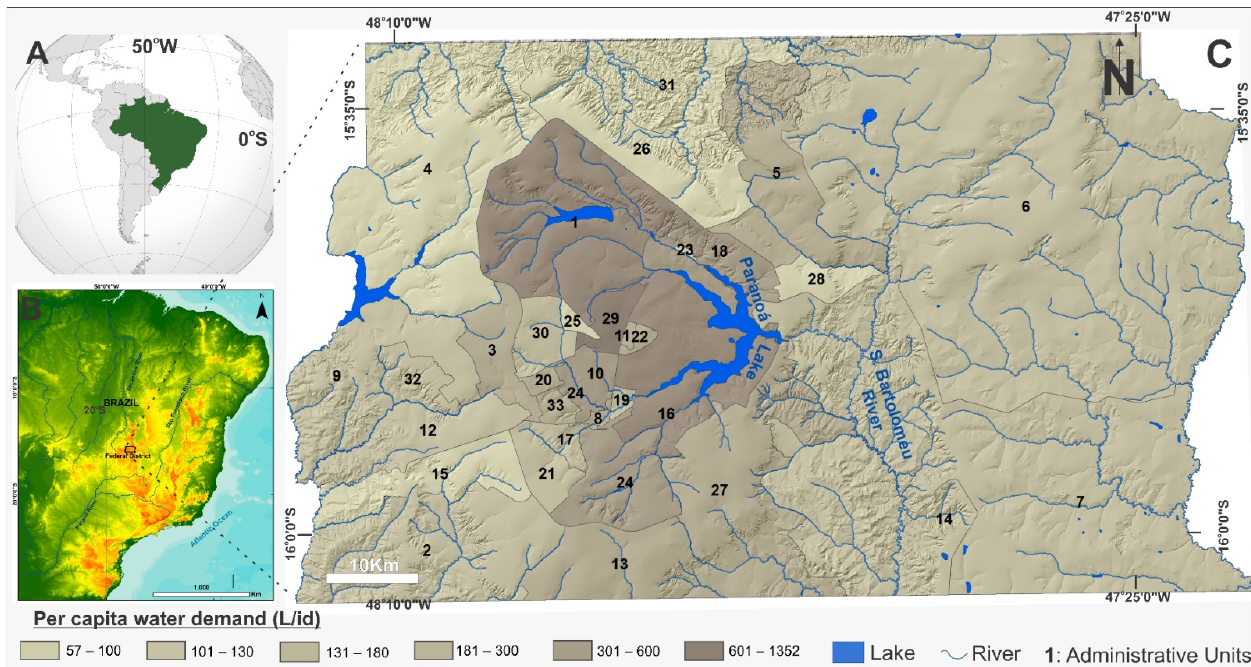
Figure 1. ( A ) Location of Brazil on South American map, ( B ) Location of Federal District (FD) on map of Brazil and ( C ) Administrative units of FD based on per capita water demand (source: [3]).